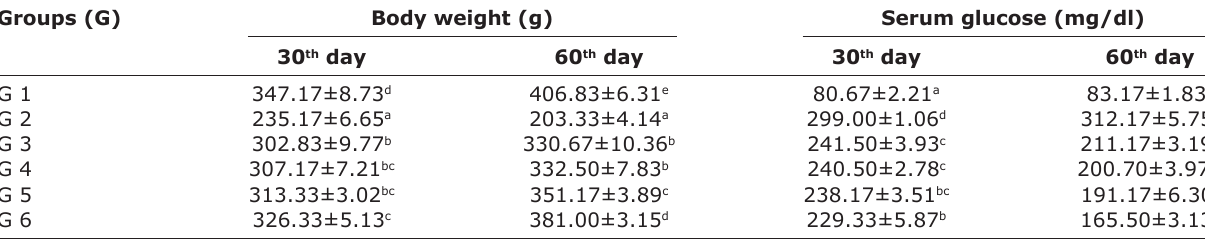
Table-1: Body weight (g) and serum glucose concentration (mg/dl) in different groups of rats. Groups (G)